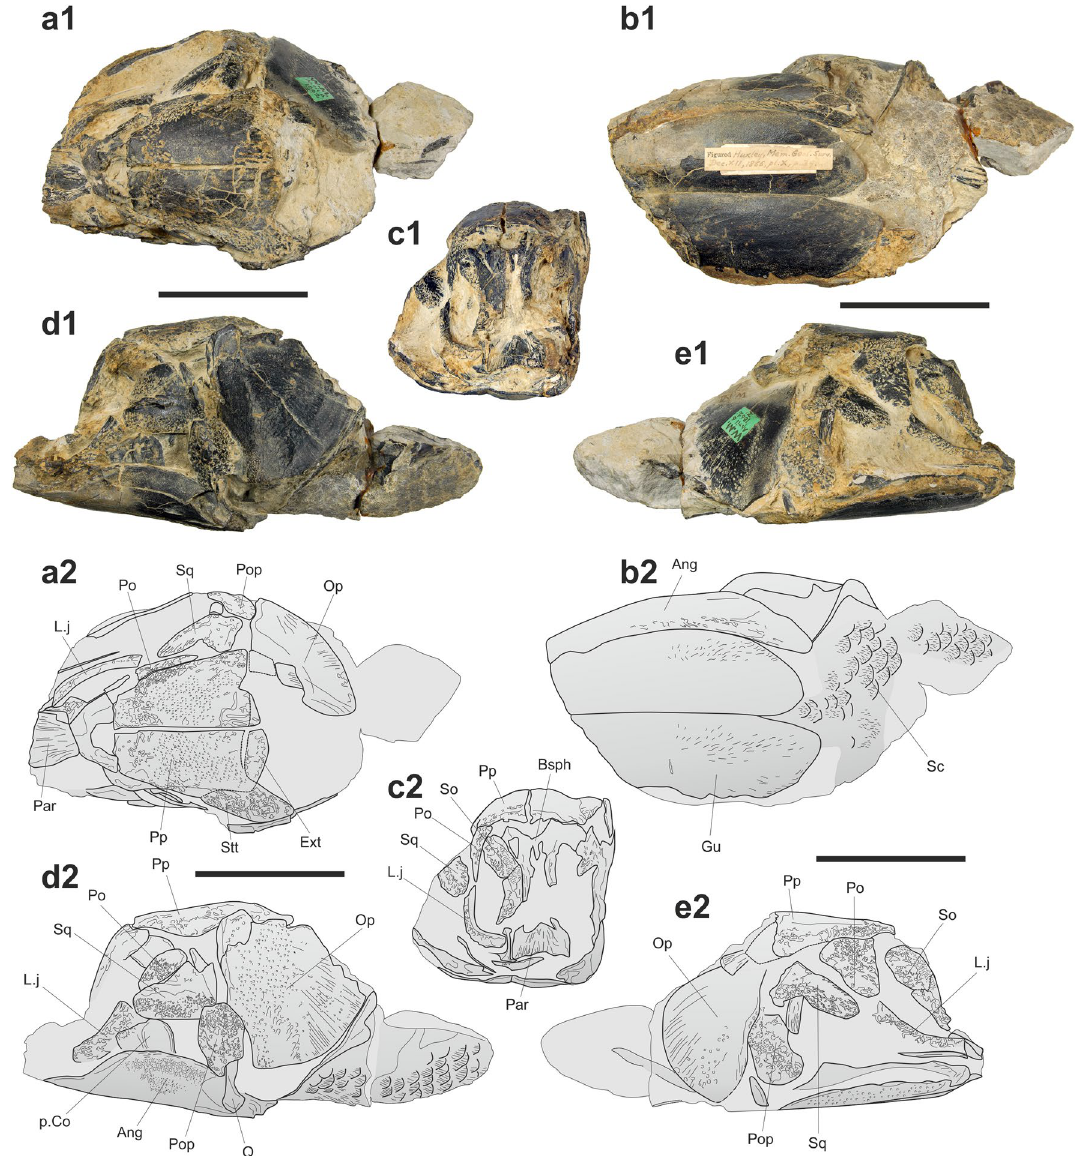
Figure 4. Trachymetopon (“ Macropoma ”) substriolatum (holotype, SMC J27415) from the Kimmeridgian of Cottenham, Cambridgeshire. Photograph ( 1 ) and semi-interpretative drawings ( 2 ) in dorsal ( a ), ventral ( b ), anterior ( c ), left lateral ( d ) and right lateral ( e ) views. Scale bars = 50 mm. Abbreviations: Ang, angular; Bsph, basisphenoid; Ext, extrascapular; Gu, gular; L.j, lachrymojugal; Op, opercle; Par, parasphenoid; p.Co, principal coronoid; Pop, preopercle; Pp, postparietal; Po, postorbital; Q, quadrate; Sc, scale; So, supraorbital; Sq, squamosal; Stt,